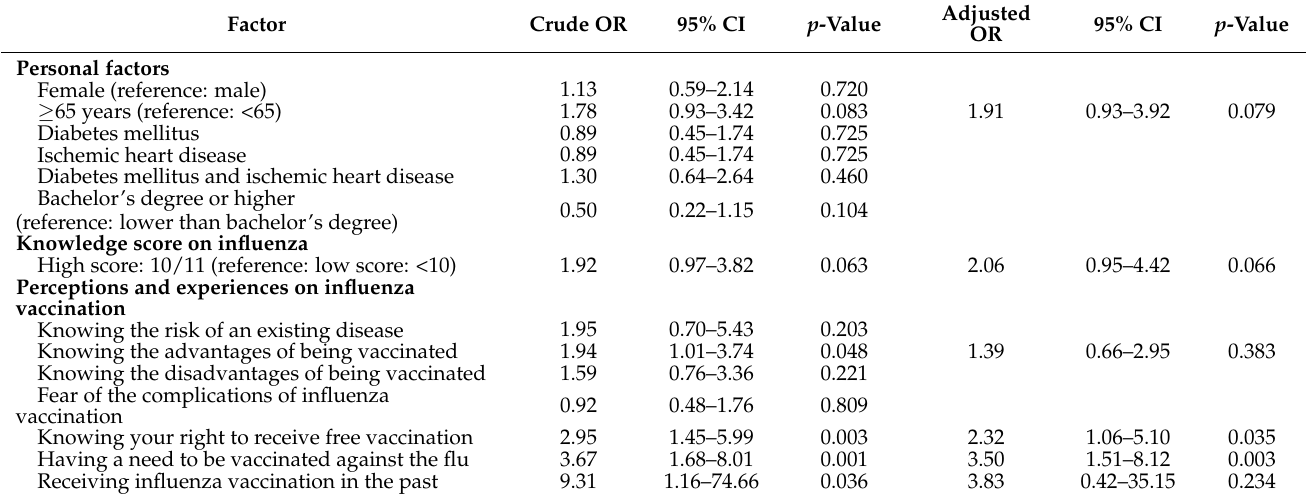
Table 2. Factors associated with influenza vaccination by univariable and multivariable logistic regression (n =